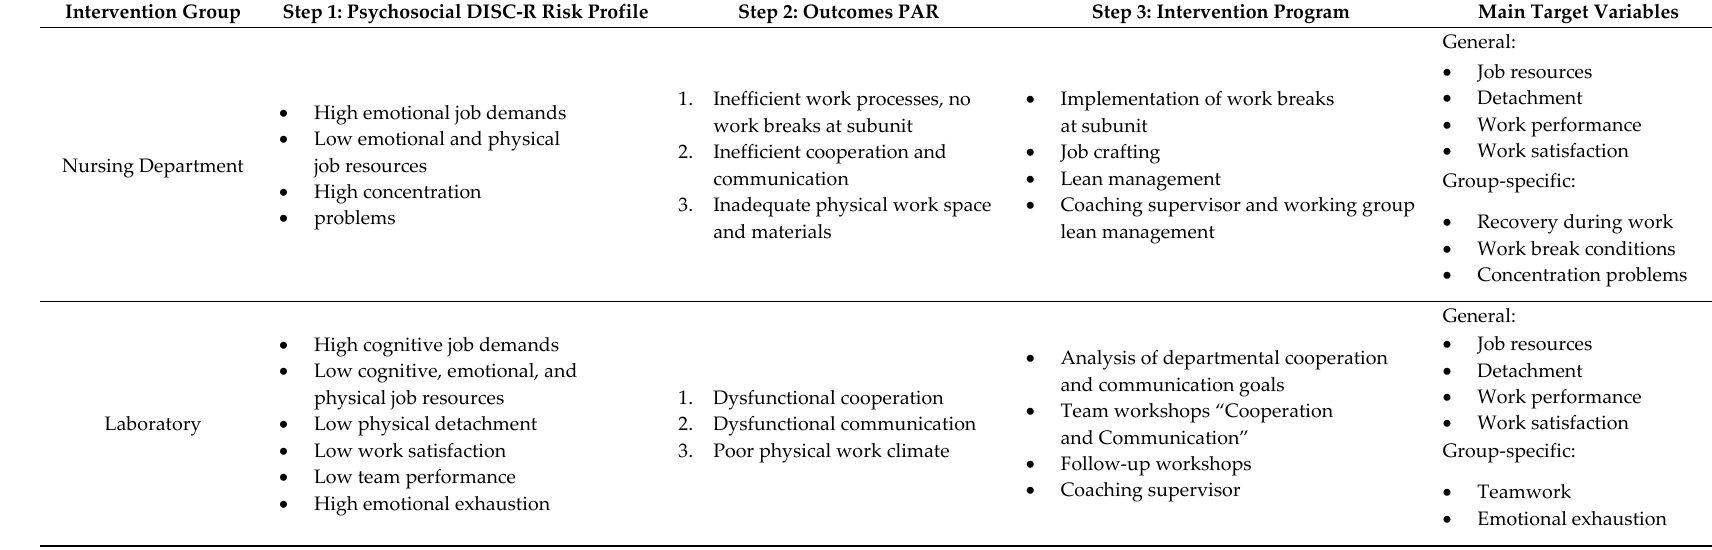
Table 2. Results of successive steps of the DISCovery method for each intervention group together with the intervention-specific target variables. Intervention